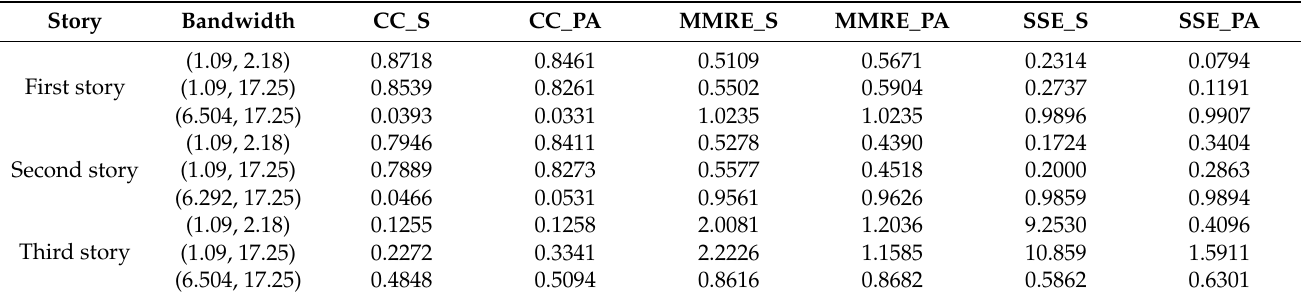
Table 6. Error analysis of IDs versus LDS for the damaged case.